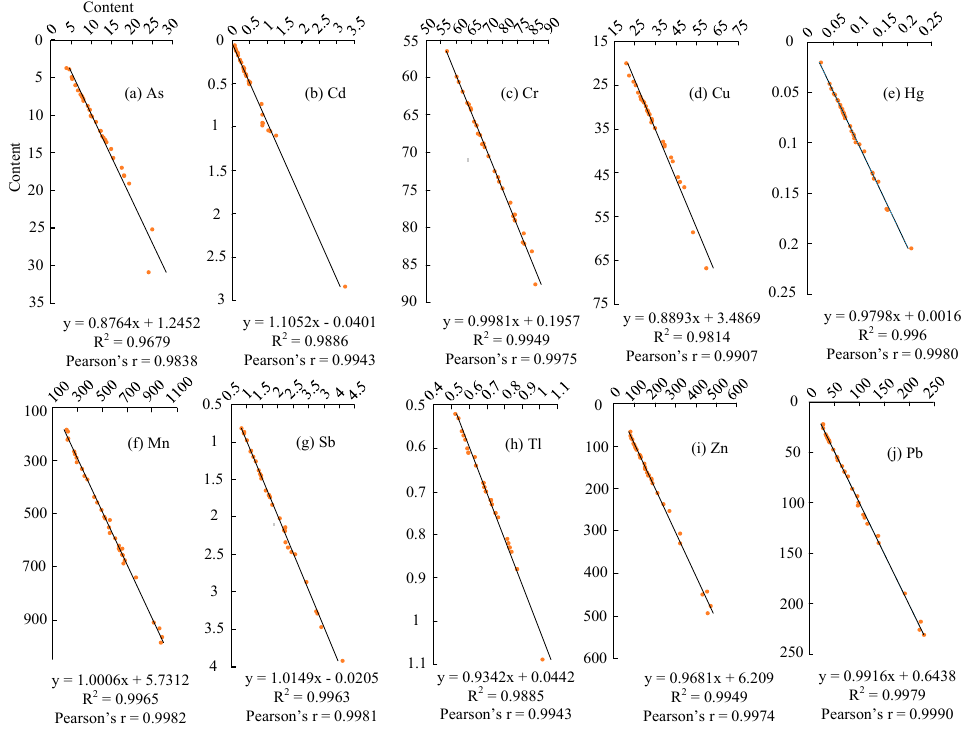
Figure 3. Feasibility verification of random forest model. Unconstructed groups of 17 pieces of data were selected as the validation of the prediction model, and groups of 17 pieces of data were substituted into the random forest values. The R 2 was as high as 0.81, and the pattern of similarity was essentially the same,